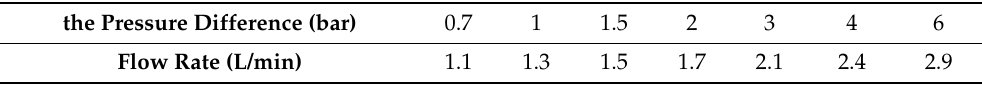
Figure 4. Nozzles arrangement. Table 2. Relationship between nozzle flow and pressure